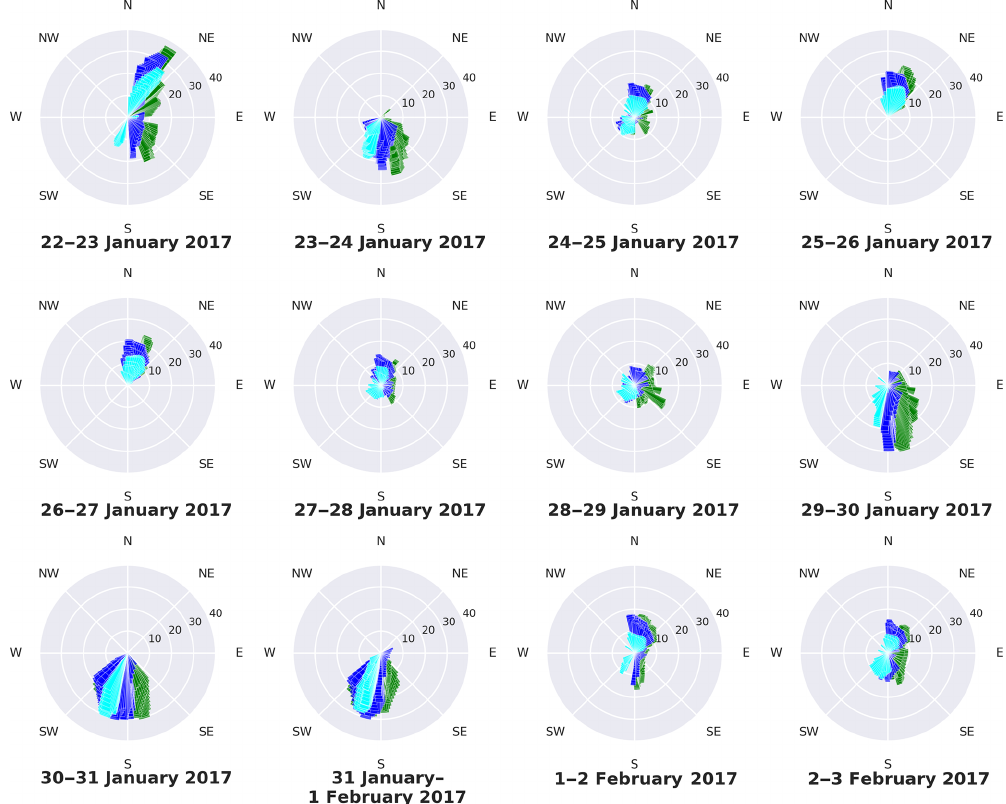
Figure 16. Wind speed (kmh − 1 ) during the formation period of the ice arch (22 January to 3 February 2017), obtained from grid points on lines 3, 4 and 5 (corresponding to latitudes 82.5, 82.25 and 82 ◦ N, respectively) of the ERA5 reanalysis shown in Fig. 3. The colours of the vectors are the same as those of the grid points in Fig. 3.